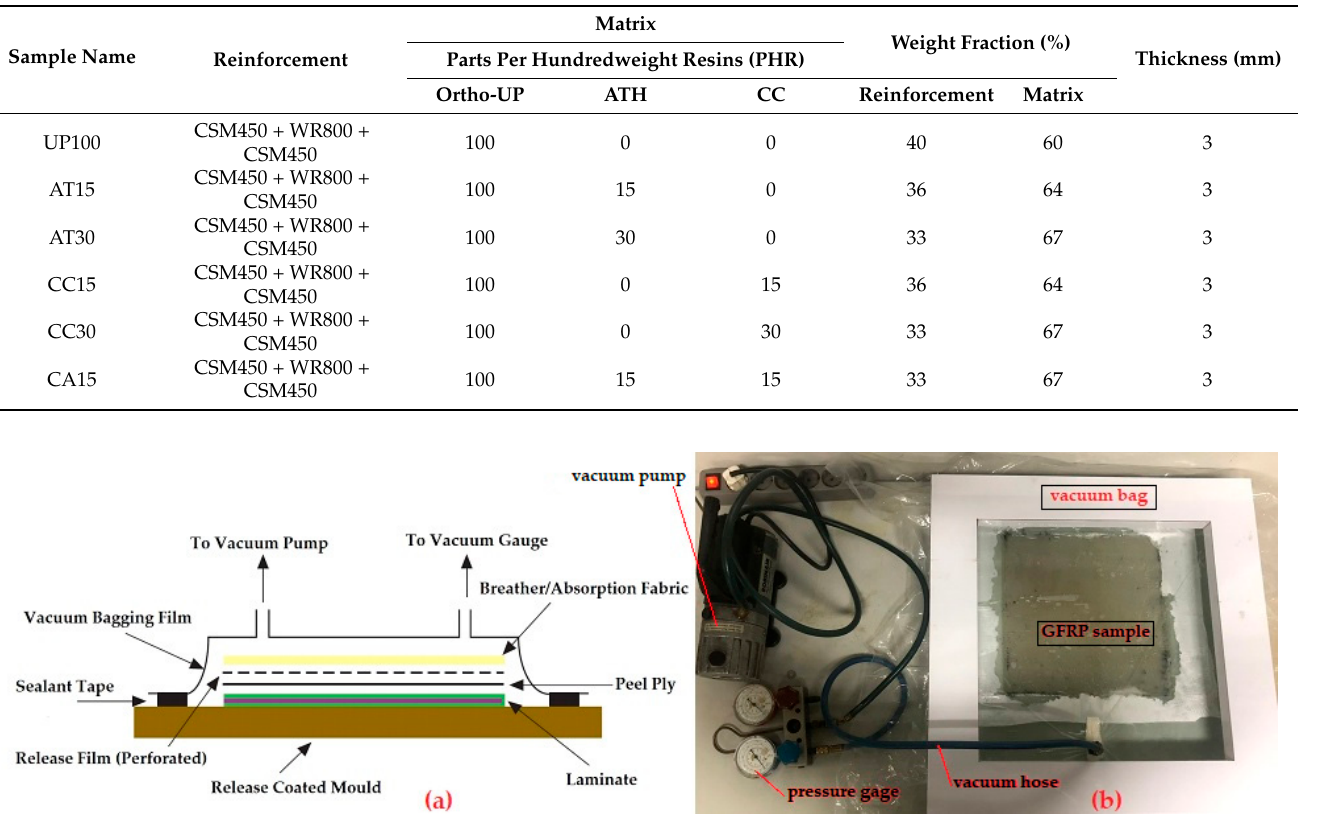
Table 1. The GFRP composite samples.